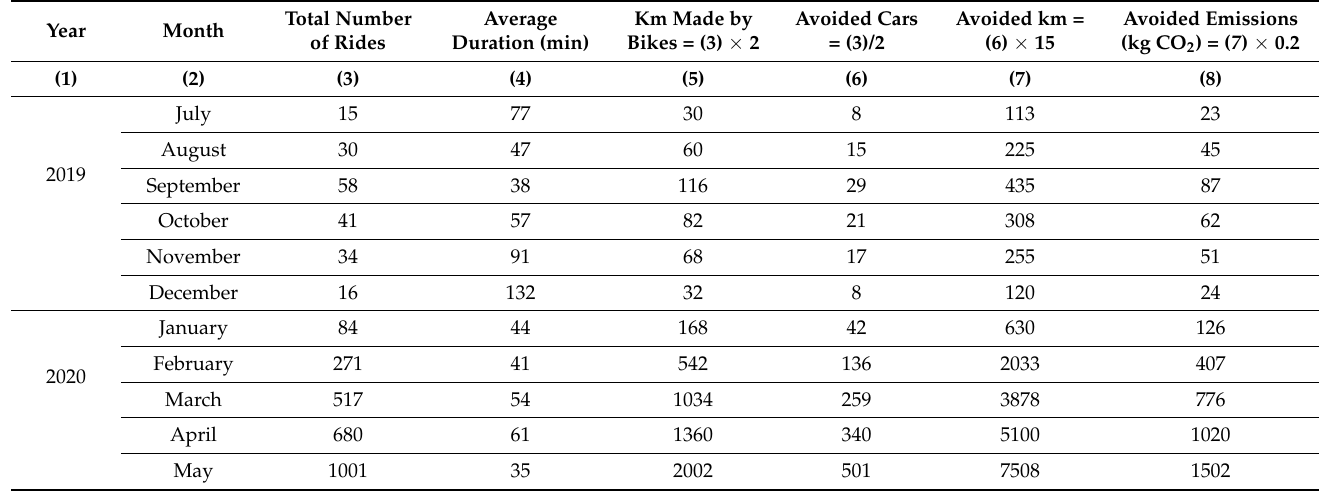
Table 5. Performance of Igoumenitsa’s BS system using the SUMPORT key performance indicators (own